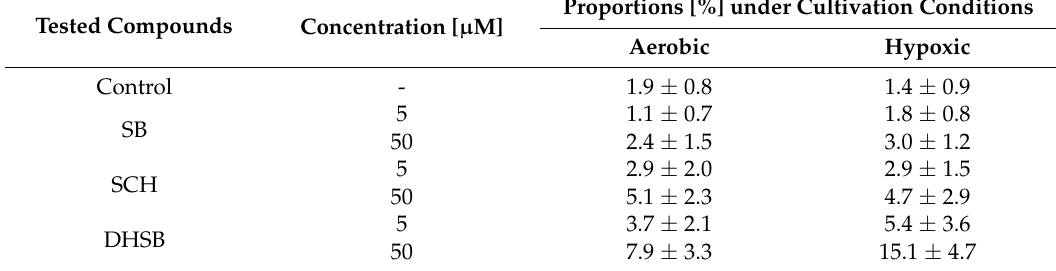
Table 2. Proportions of dead larvae out of total counted larvae (in %) evaluated under inverted microscope after three days of cultivation under both aerobic and hypoxic conditions. Dead larvae were assessed according to the loss of movement and disintegrated